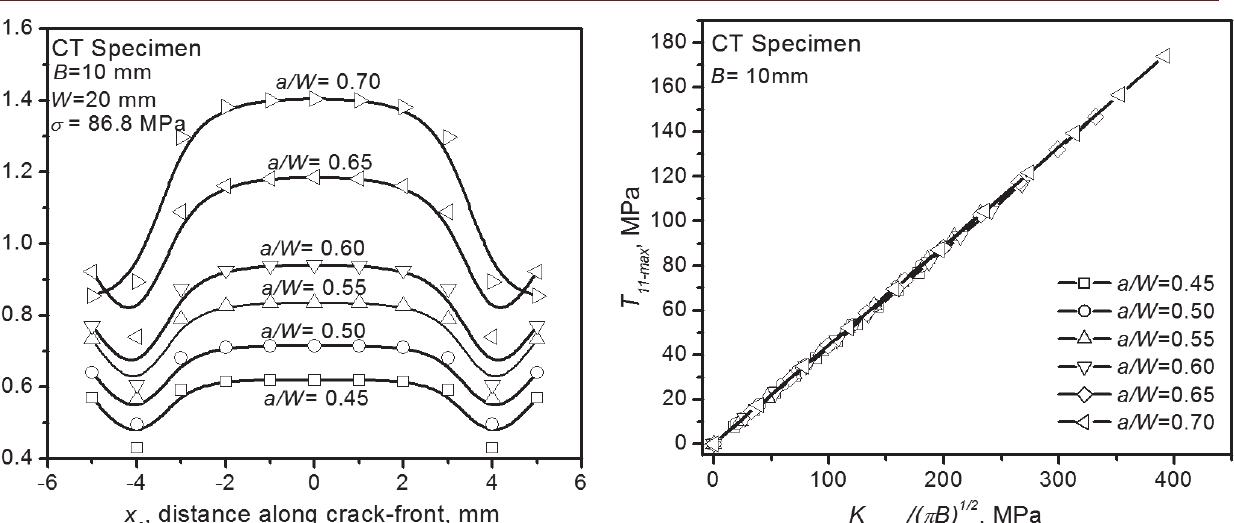
Figure 6: A typical variation of T 11 /  along the crack-front for various a/W and B =10mm.